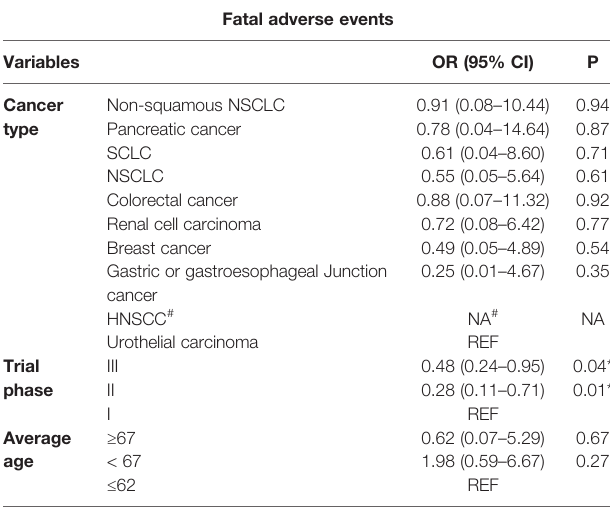
TABLE 3 | Results of multivariate meta-regression of fatal adverse events associated with PD-L1